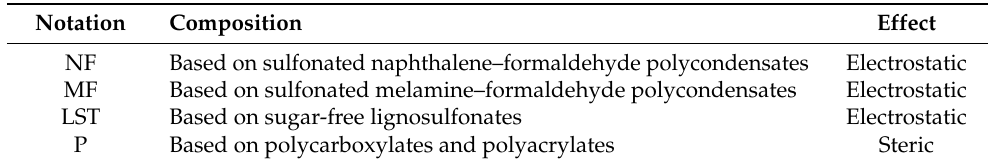
Table 1. Classification of